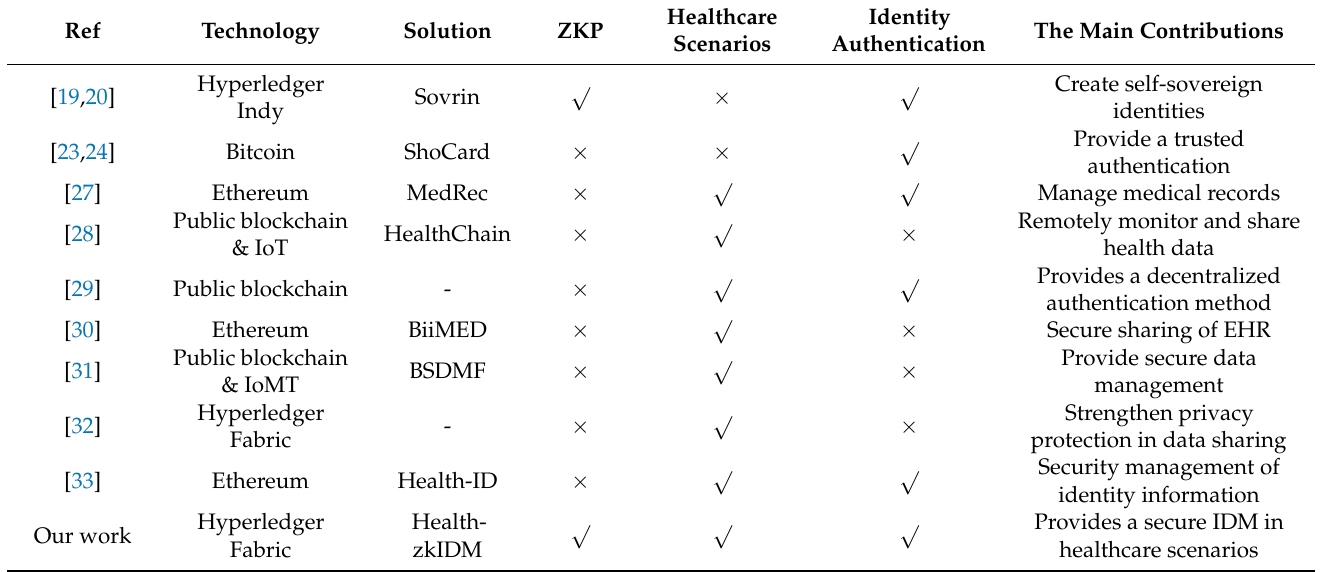
Table 1. Comparison of related